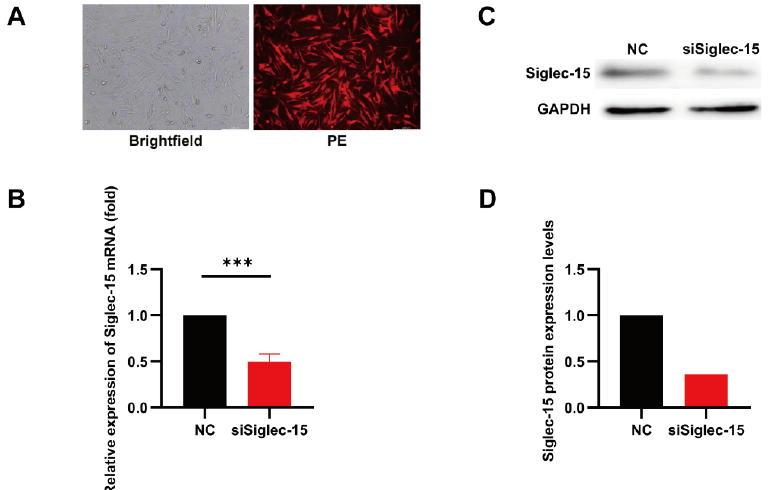
Figure 3. Knockdown of Siglec ‐ 15 expression in GCTB stromal cells. ( A ) The transfection efficiency was observed under a fluorescence microscope. ( B ) The silencing efficiency was determined by RT ‐ PCR assay. ( C , D ) The silencing efficiency was determined by Western blotting. *** p < 0.01. Scale bars, 200 μ m.